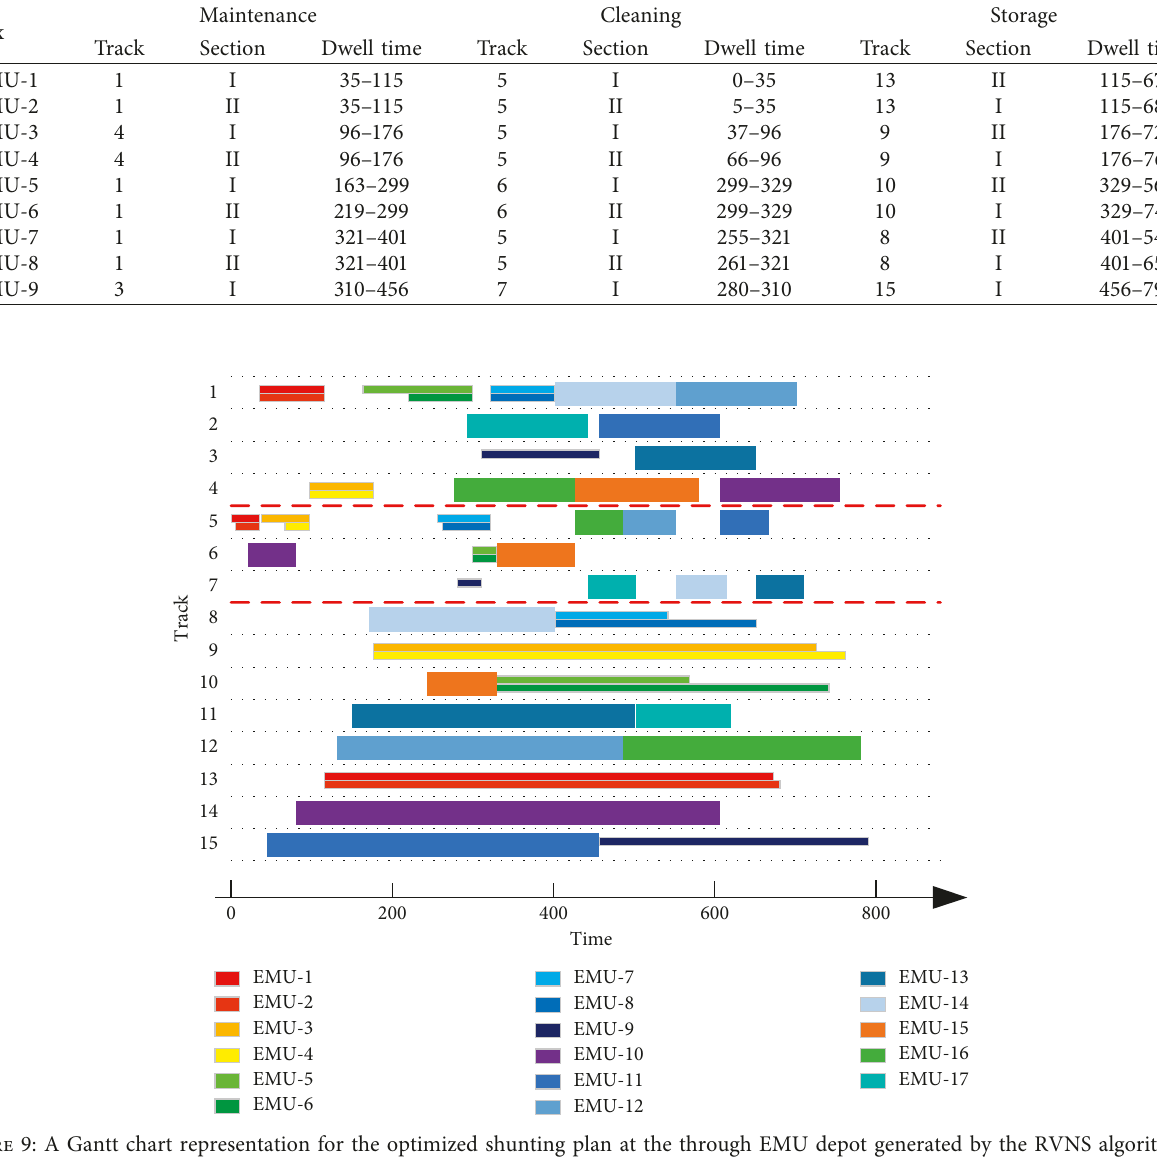
Table 9: The shunting operation plan of S-EMUs at the stub-end EMU depot generated by the RVNS algorithm.